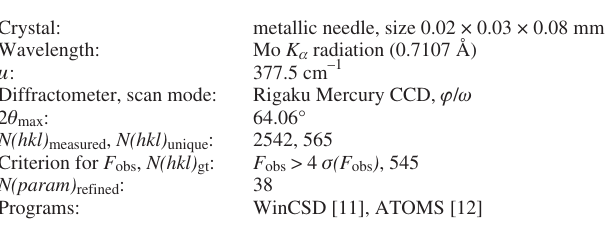
Table 1. Data collection and